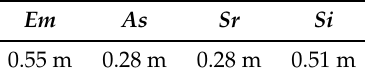
Table 4. Mean absolute distance offset to Dy per auralization technique over all tested beam directions ϕ S